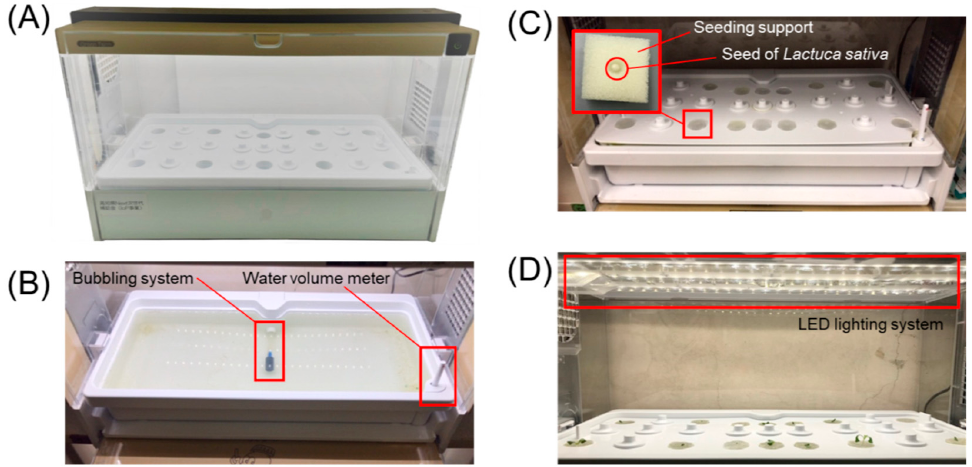
Figure 1. Closed hydroponic system used in this study. ( A ) Photo of the whole system, ( B ) storage of fertilizer solution with bubbling system and water volume meter, ( C ) seeding panel and support with seeds of Lactuca sativa , and ( D ) LED lighting system of the hydroponic system.